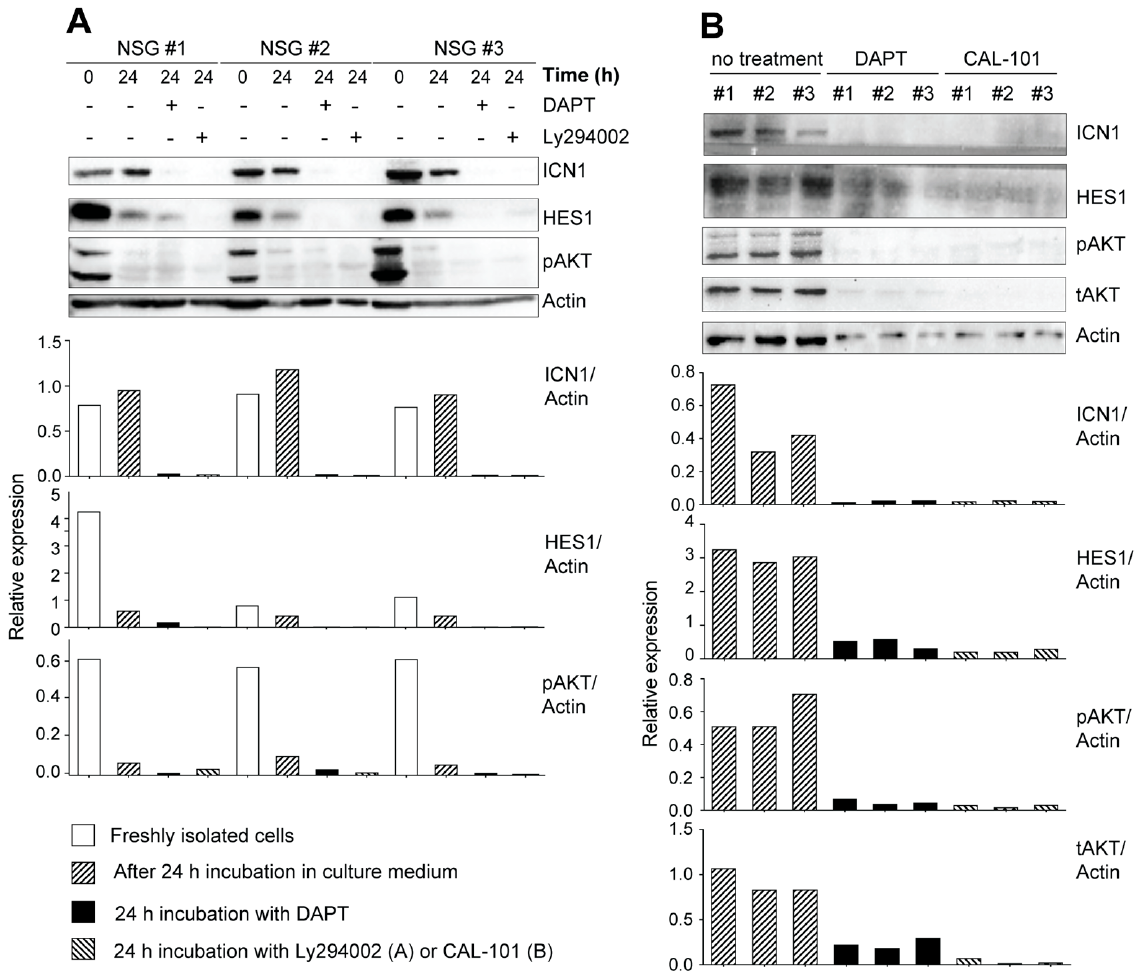
Figure 5. Increased NOTCH1 activation in primary leukemic cells from IL-15-deficient Scid mice. ( A ) Freshly isolated leukemic cells originating from a NOD. Scid.Il15 − / − mouse were passaged in NSG mice to increase cell yield. Single-cell suspensions from the lymph node cells of recipient mice were lysed immediately after isolation or after 24 h incubation in the presence or absence of the gamma secretase inhibitor DAPT (10 µ M) or the PI3K inhibitor LY294002 (10 µ M) and analyzed for the expression of ICN1 and HES1 by Western blotting. ( B ) Leukemic cells originating from three independent C57BL/6. Scid.Il15 − / − mice were incubated with DAPT or a PI3K inhibitor CAL-101 (25 µ M) for 24 h and analyzed for the expression of ICN1, HES1, phospho-AKT and total-AKT. Representative data from one of the two similar experiments are shown. The densitometry quantification of ICN1, HES1, pAKT and tAKT bands normalized to the corresponding actin band for each sample is graphically represented below the blots. Original Western blots are given in Supplementary Figure